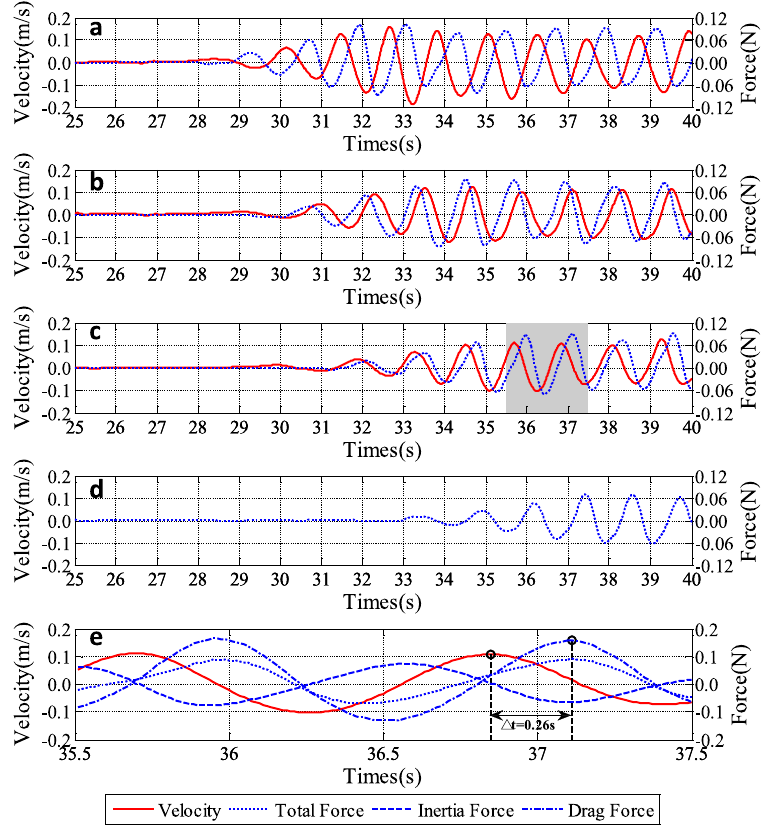
Figure 5. ( a – d ) Raw velocity and total force data measured at four locations (1–4) in the order of the wave propagation in the mimicked vegetation canopy; ( e ) The shaded area in panel ( c ) is blown up in panel ( e ) for detailed analysis, where inertia force and drag force were derived based on non-synchronized data. The time shift ( ∆ t) between the F D and U is 0.26 s. The shown test case is wave0712 with 7 cm wave height and 1.2 s wave period. The velocity data in panel ( d ) is not included, due to the ADV measurement failure at location 4.